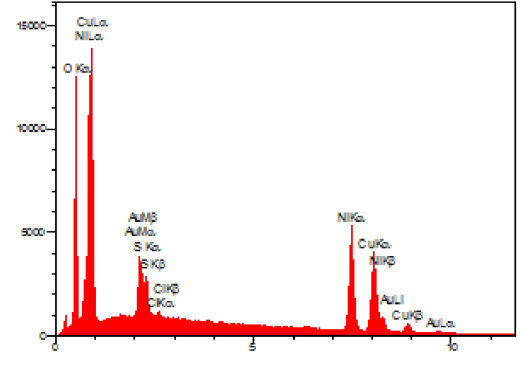
Fig. 2. EDX spectra of B sample (nano-composite containing high Cu content) after